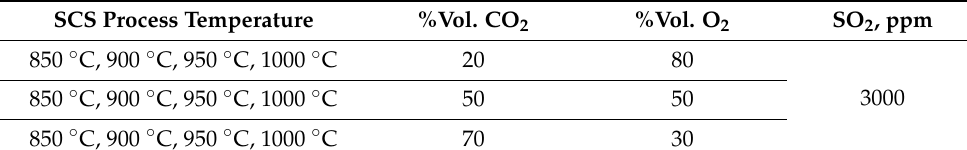
Table 4. Experimental conditions used for the analysis of sorbent properties during oxy-combustion.